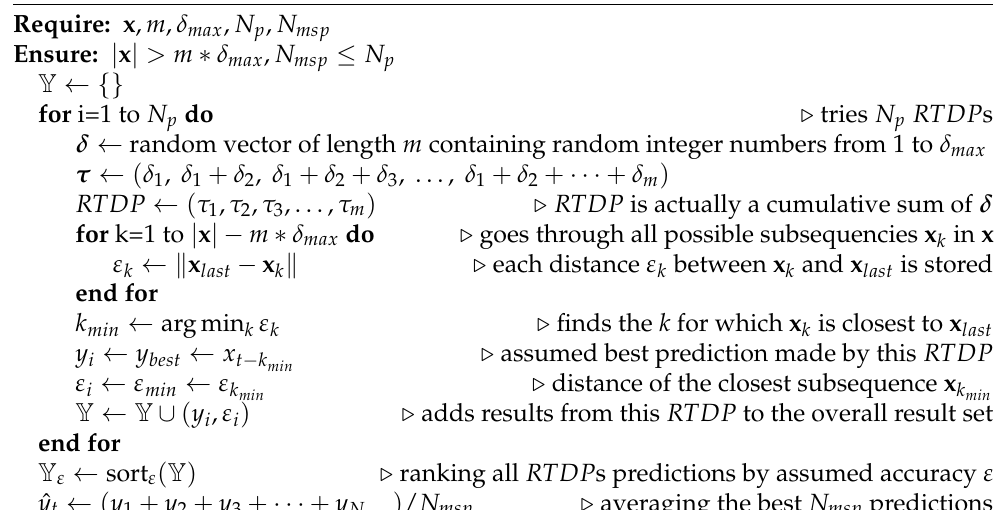
Algorithm 1 The RTDP method in